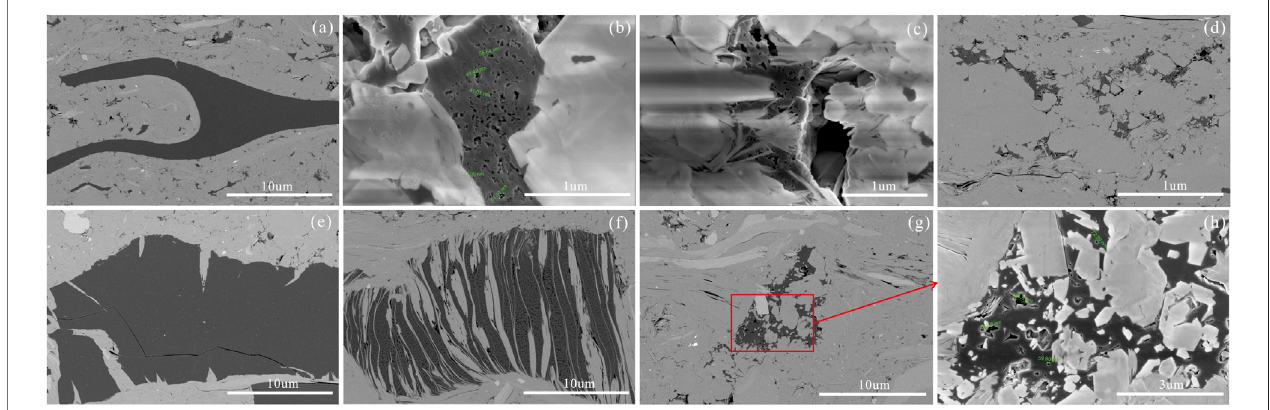
FIGURE 7 | SEM images of ORS shale samples in the Shahezi Formation. (A – D) LFS1-22; (E – H) LFS1-9. (A) Organic debris with little internal pores; (B) microporesdevelopedinthebitumen; (C) intergranularporesarewelldeveloped,and themicroporesintheedgeofbitumenarewelldeveloped; (D) quartzintergranular poresandclayshrinkagecracksarewelldeveloped; (E) organicdebriswithlittlepores; (F) bitumenis fi lledbetweenclaylayers; (G) clayshrinkagecracks; (H) micropores are developed in the bitumen which is fi lled between quartz.